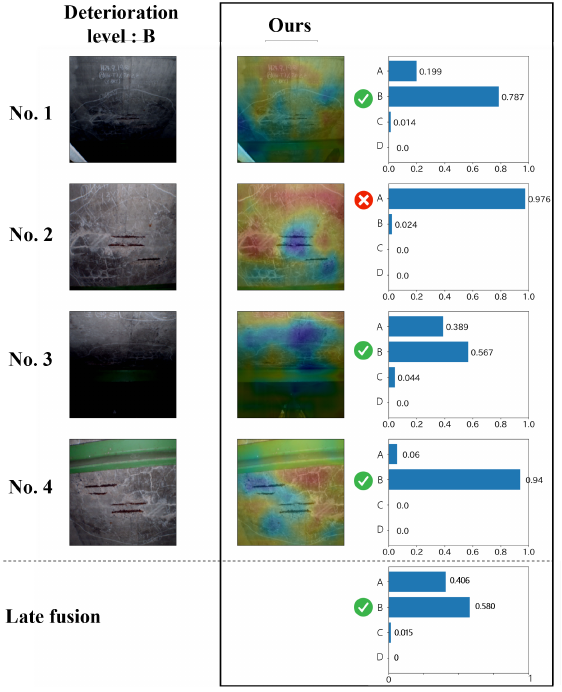
Figure 11. The example of the case that the most confident result is likely to be wrong.